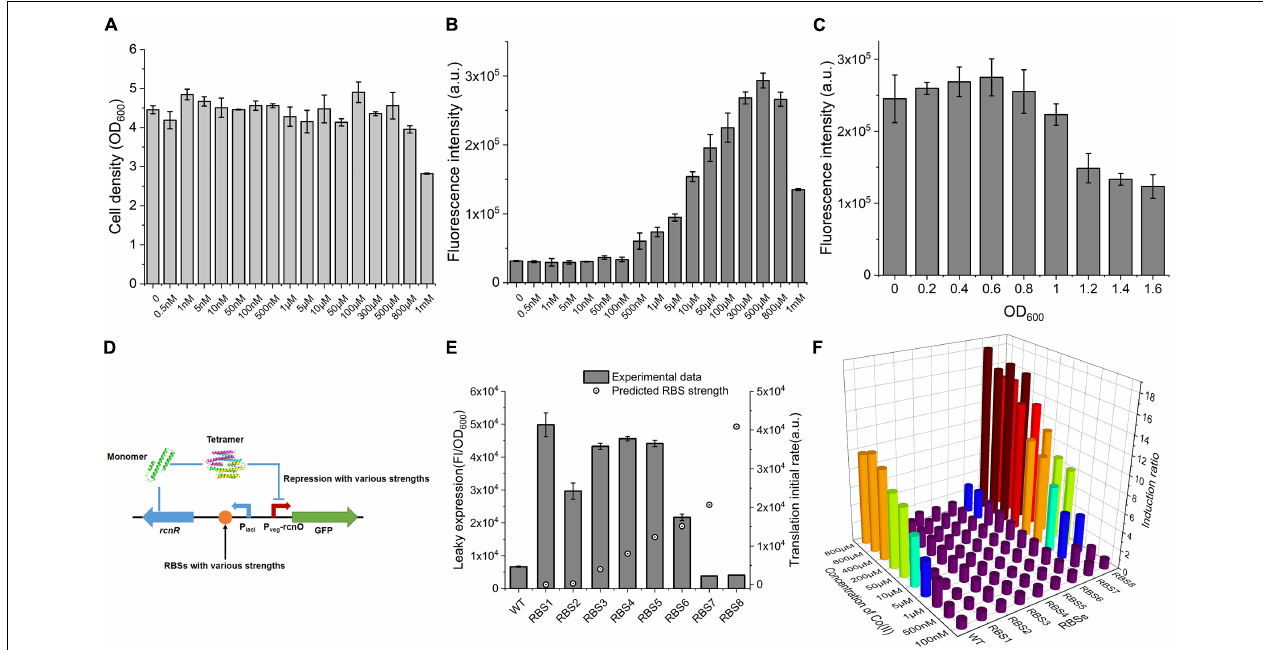
FIGURE 2 | Characterization of CIES. (A) The influence of concentration of Co(II) on cell growth. (B) The influence of concentration of Co(II) on GFP expression. (C) The influence of induced occasion on GFP expression. (D) Schematic diagram of various repression strengths by various RcnR expression strengths. (E) The negative correlation between RcnR expression strength and leaky expression. (F) Determination of induction ratio under combinations of different RcnR expression strengths and different concentrations of Co(II). All error bars in figures presented root-mean-square deviation of three separate experiments. FI: Fluorescence